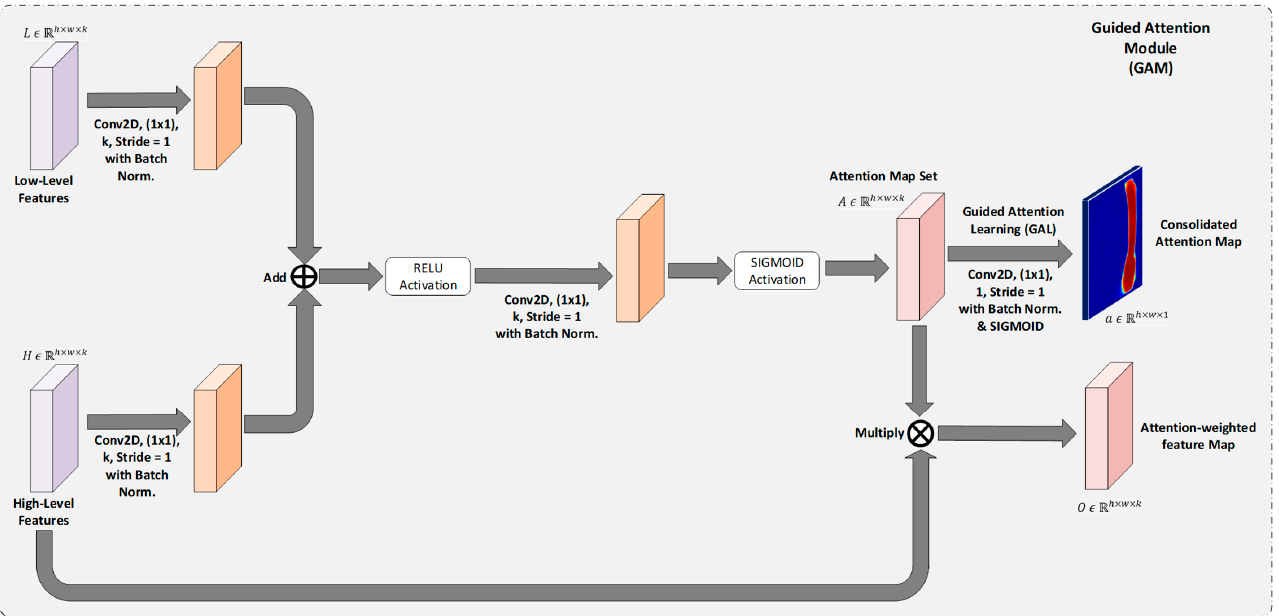
Figure 3. The overview of the Guided Attention Module with Guided Attention Learning.